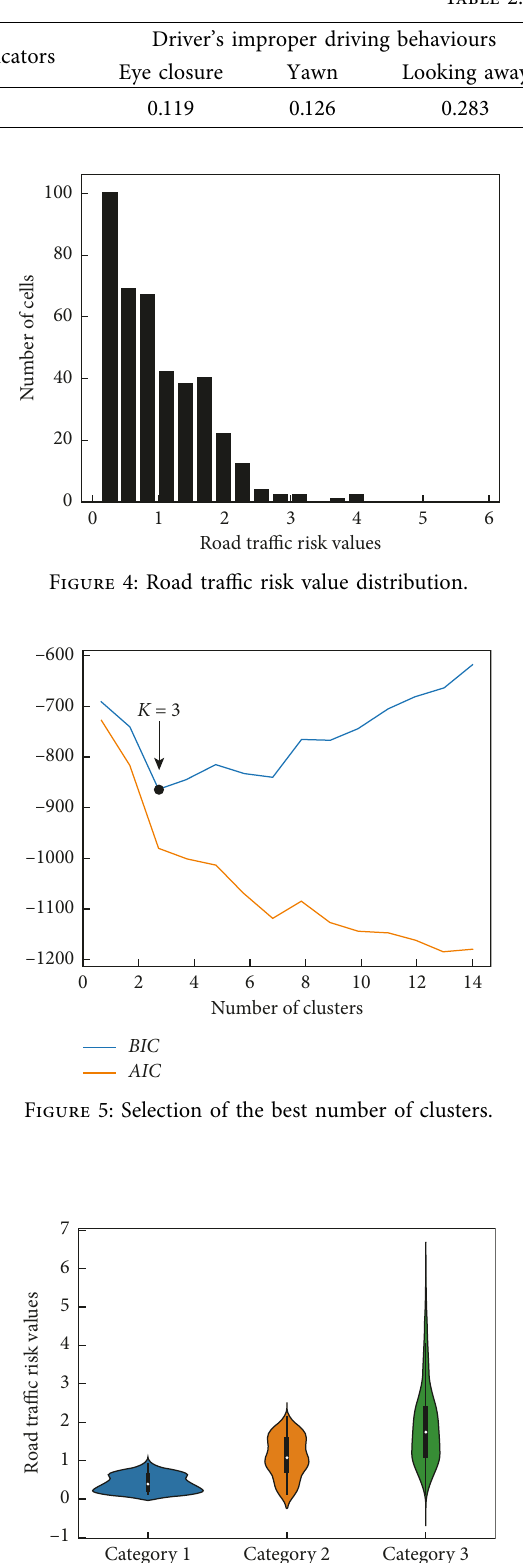
Table 2: Risk liability weight.